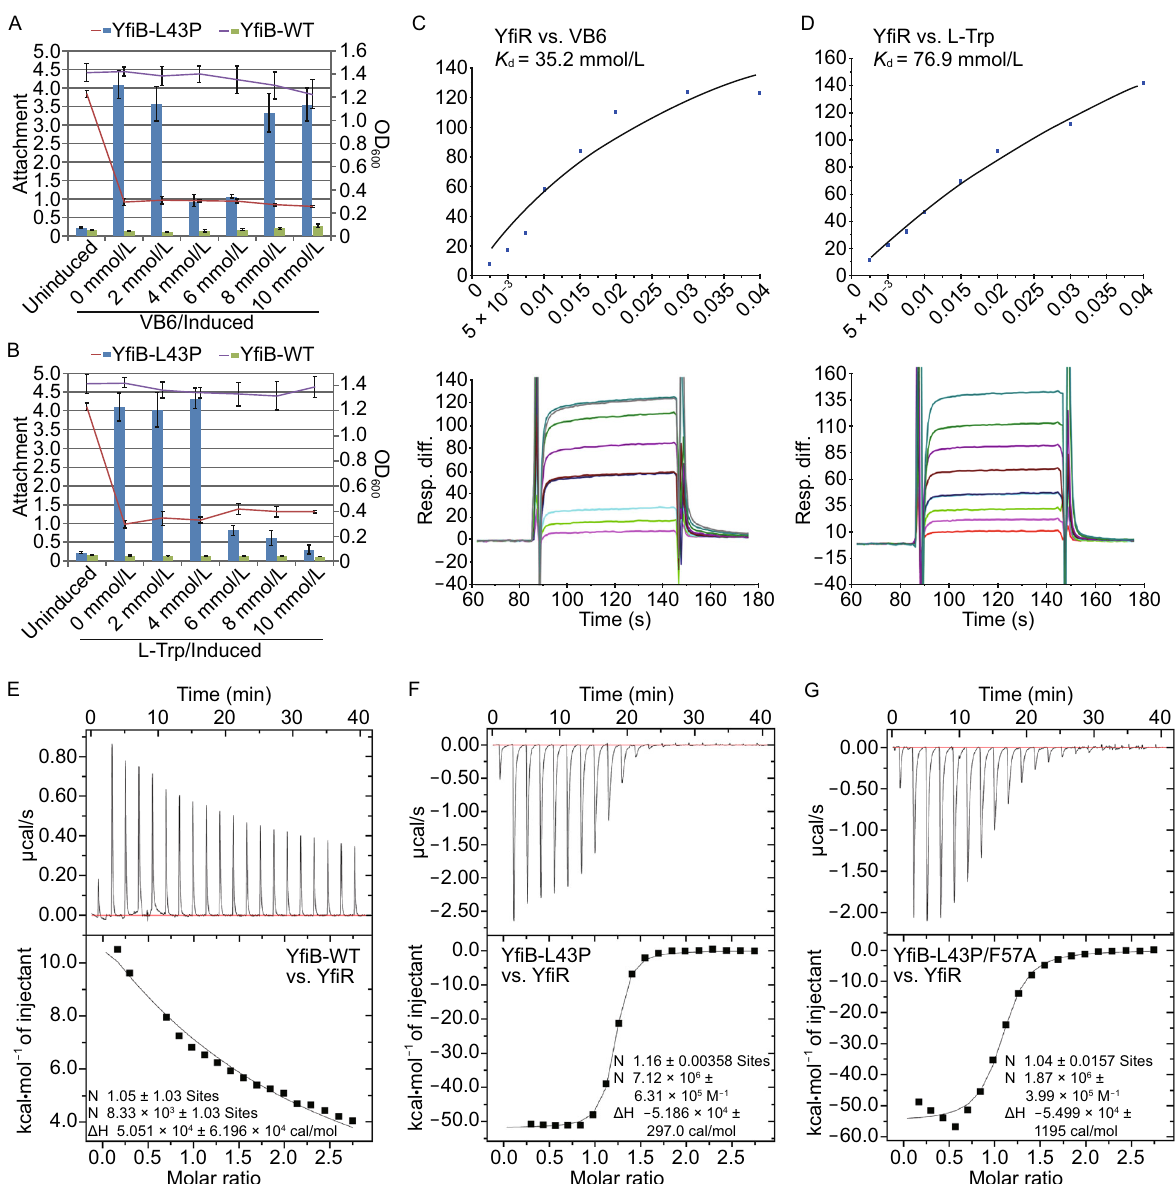
Figure 6. Functional analysis of VB6 and L-Trp. (A and B) The effect of increasing concentrations of VB6 or L-Trp on Y fi B L43P - induced attachment (bars). The relative optical density is represented as curves. Wild-type Y fi B is used as negative control. (C and D) BIAcore data and analysis for binding af fi nities of (C) VB6 and (D) L-Trp with Y fi R. (E – G) ITC data and analysis for titration of (E) Y fi B wild-type, (F) Y fi B L43P , and (G) Y fi B L43P/F57A into Y fi